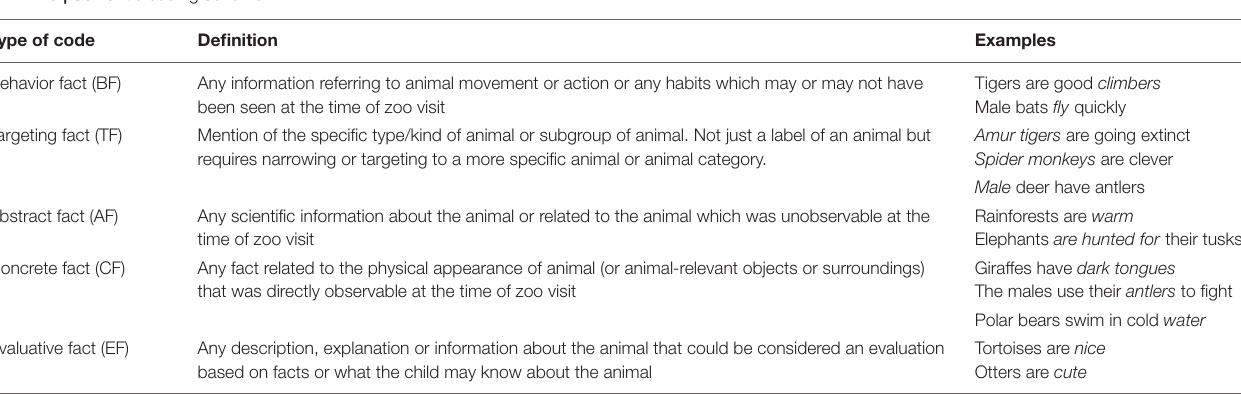
TABLE 3 | Semantic coding